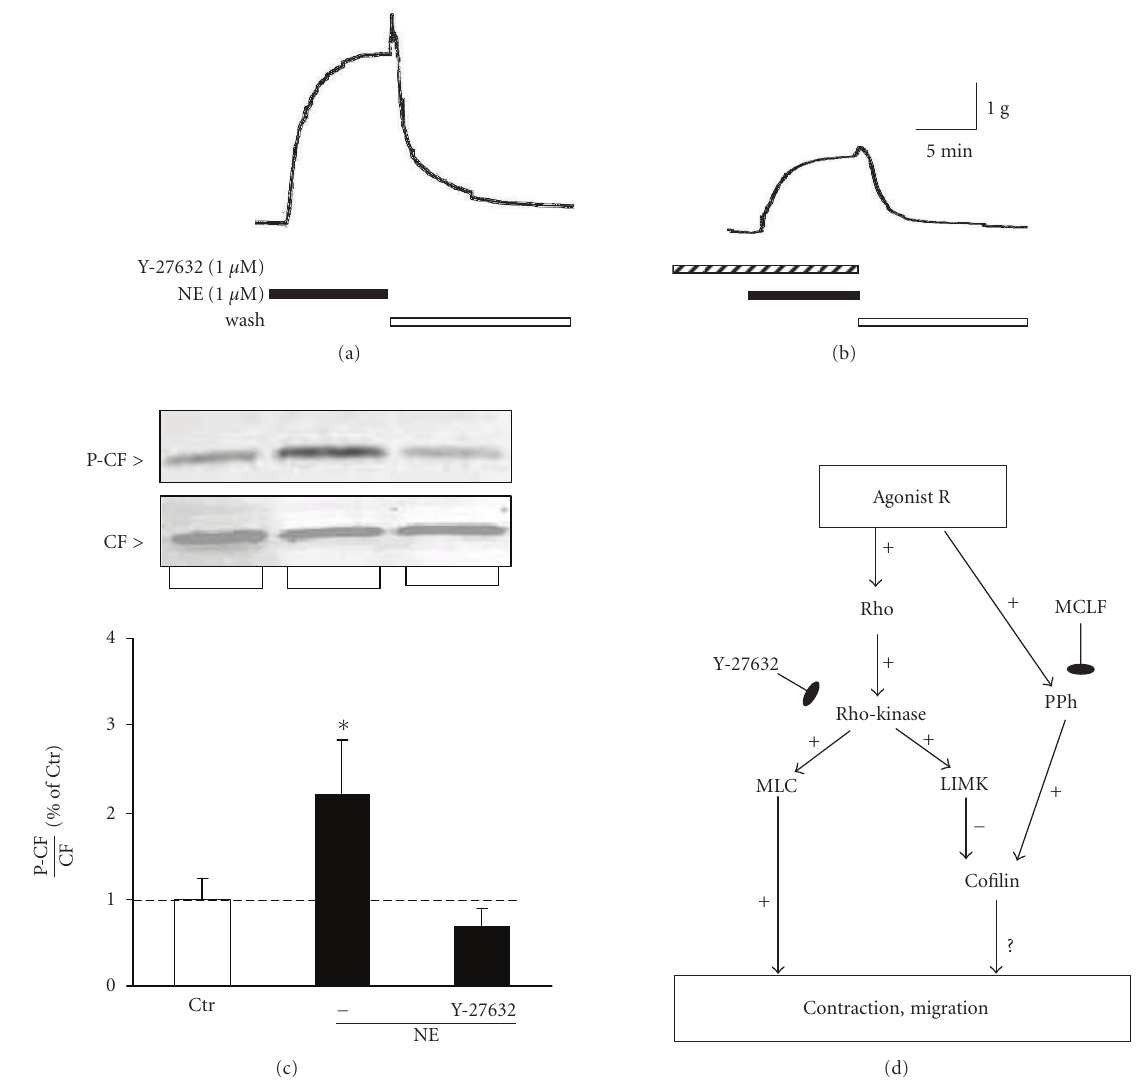
Figure 2: Norepinephrine-(NE) induced contraction and CF phosphorylation of PA rings were attenuated by the Rho-kinase inhibitor Y-27632. Freshly dissected canine PA rings were incubated with 1 μ M NE without (panel (a)) or after 1-hour preincubation with Y-27632 (1 μ M panel (b)). Strips were snap-frozen at the maximal contraction amplitude and homogenized. Total protein was resolved by SDS-PAGE and transferred onto nitrocellulose membranes. CF and P-CF were assayed by immunoblotting (panel (c)). Immunoreactive P-CF band densities (panel (c), top inset) were normalized to immunoreactive CF bands (panel (c), bottom inset), and treatment-induced changes in P-CF/CF ratio were expressed as percent of unstimulated controls (Ctr, bar graph). Panel (d): Schematic of signal transduction leading to phosphorylation of cofilin and documented CF-mediated cell functional responses. Abbreviations: Agonist R, agonist receptor; Rho, Rho GTPases; MLC, myosin light chain; LIMK, LIM kinase, PPh, protein phosphatases, MCLF, microcystin LF. Mean ± SD, ( ∗ ) P < . 05 compared to untreated controls, n =